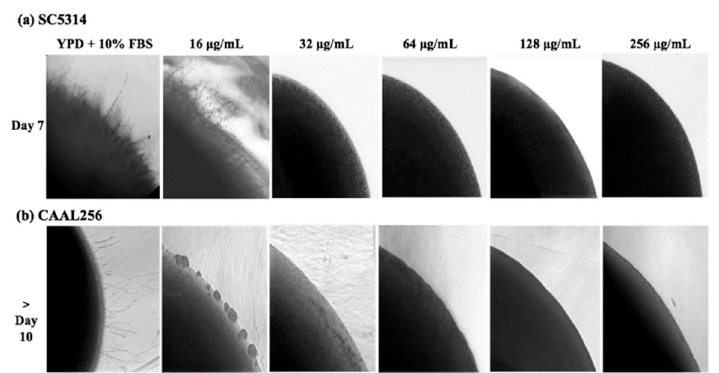
Figure 4. Effect of ethanolic extract of P. nigrum on filamentation of C. albicans on solid medium containing YPD plus FBS. C. albicans ( a ) SC5314 and ( b ) CAAL256 strains. Images were taken at 40× magnification.